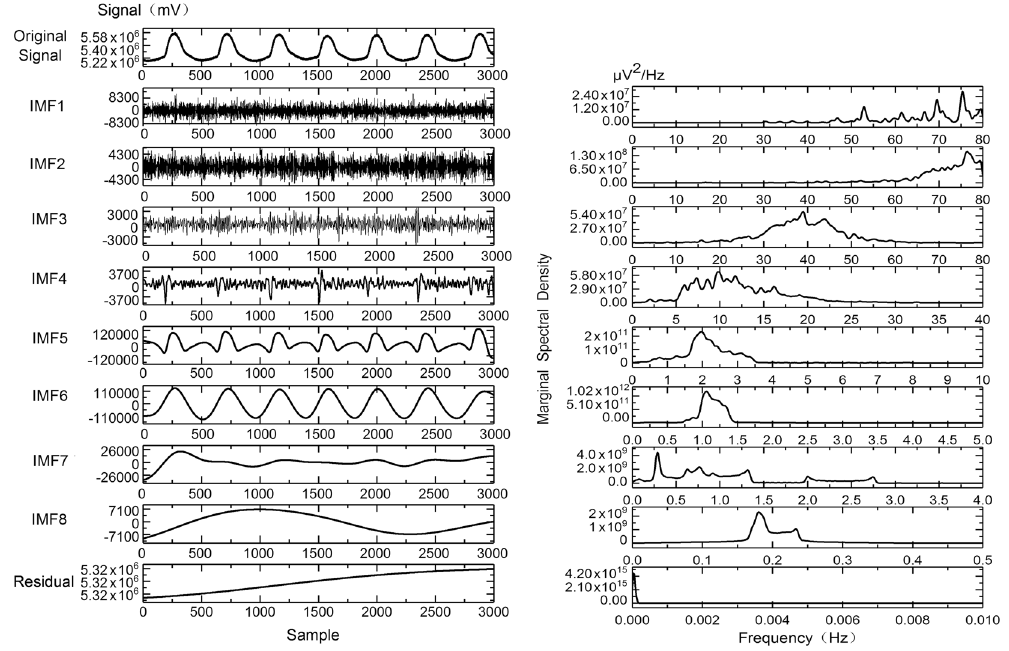
Figure 2. Six-second digital volume pulse (DVP) signals from a testing subject with 3000 samplings at a frequency of 500 Hz undergoing ensemble empirical mode decomposition (EEMD) resulting in the generation of 8 intrinsic mode functions (IMFs) and residual r 8 ( t ) (Left panel). Through Hilbert–Huang spectrum analysis, the instantaneous frequency corresponding to different energy can be obtained for each IMF (Right